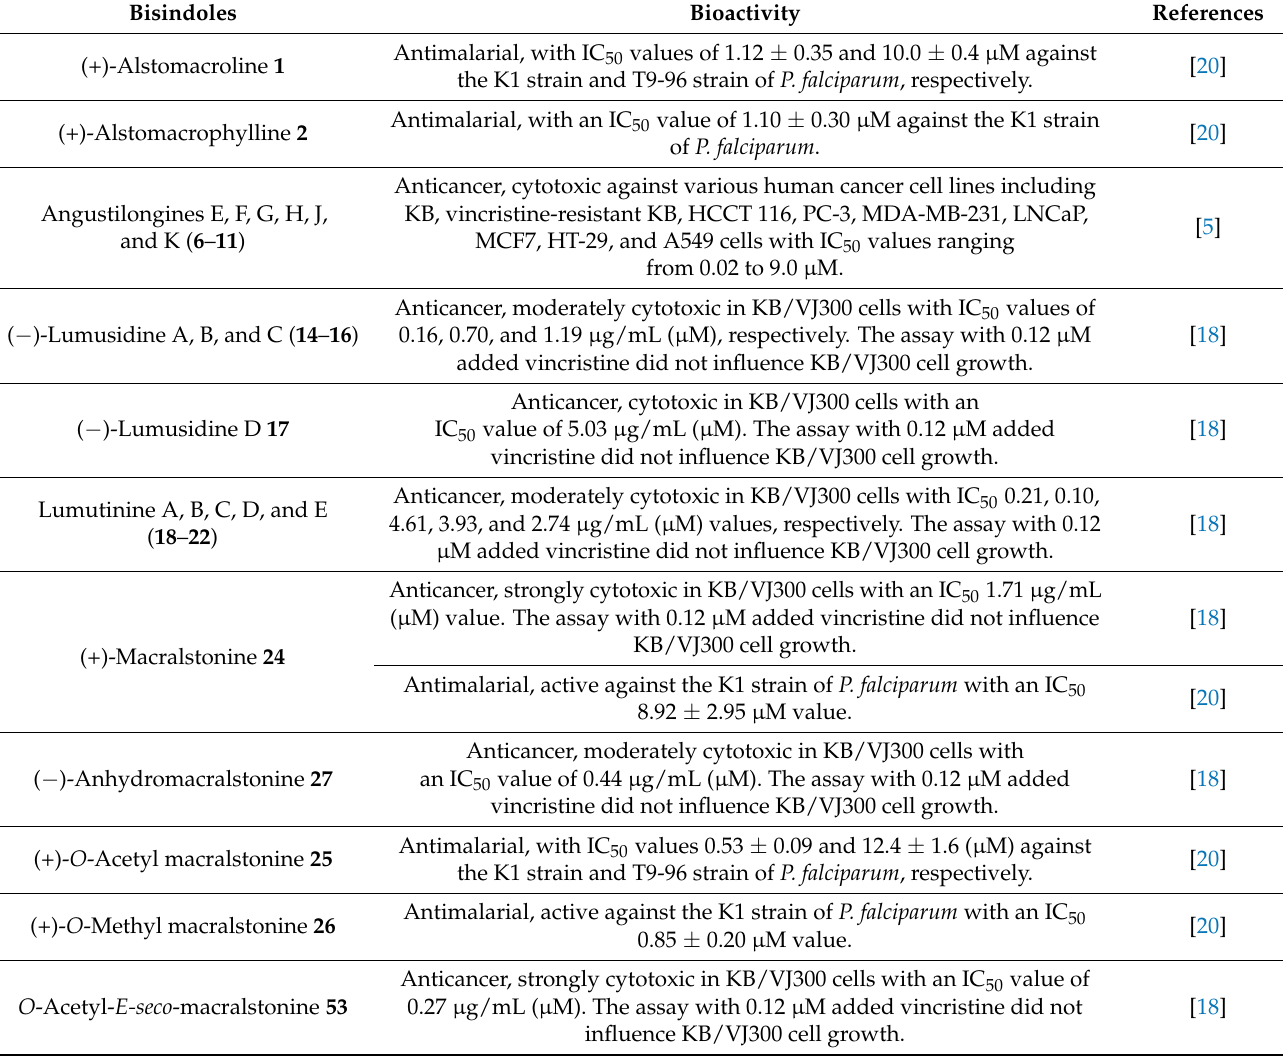
Table 4. Bioactivity of bisindole alkaloids (including semisynthetic derivatives) from Alstonia species. Bisindoles